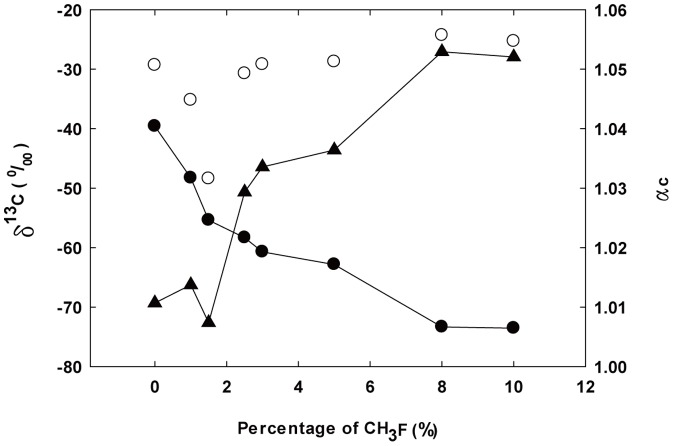
Temporal changes in δ
13CH4, δ
13CO2 and α
c at day 6 under different CH3F levels.
δ
13CH4 (solid circle), δ
13CO2 (open circle), α
c (solid triangle).